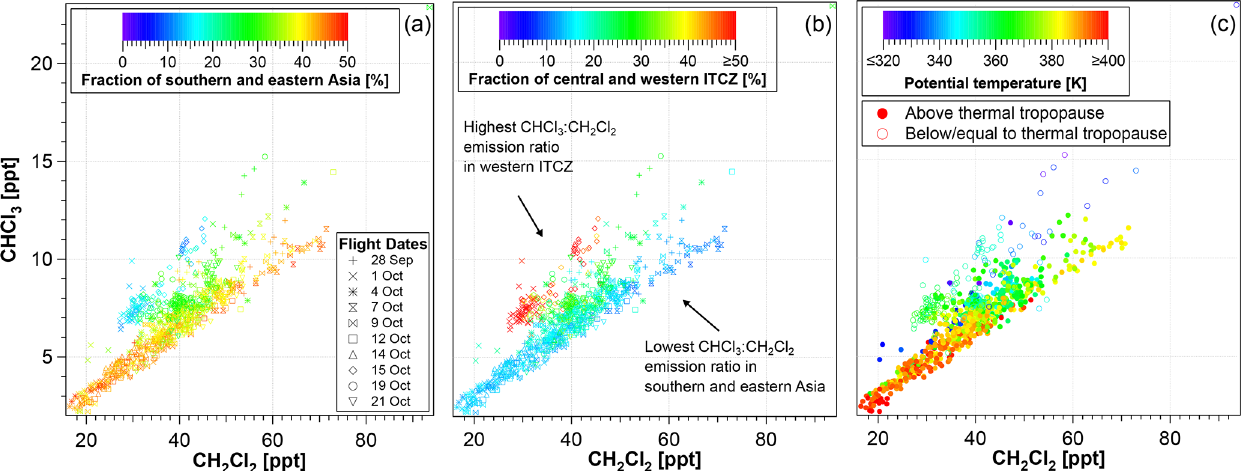
Figure 13. CHCl 3 –CH 2 Cl 2 relationship, color coded with the SaEA (a) and the W-ITCZ (b) surface origin tracer, and the potential temper- ature (c) . The relationship exhibits different correlation slopes clearly depending on the origin of air. A large impact of sources from southern and eastern Asia coincides with a low correlation slope dominating the larger part of the relationship. A large impact of sources from the central and western part of the ITCZ coincides with the steepest correlation slope, implying a larger CHCl 3 :CH 2 Cl 2 emission ratio in this region compared to the emission ratio in southern and eastern Asia. The highest CHCl 3 mixing ratios and the majority of measurements with the steepest correlation slope were observed in the tropopause region and the upper